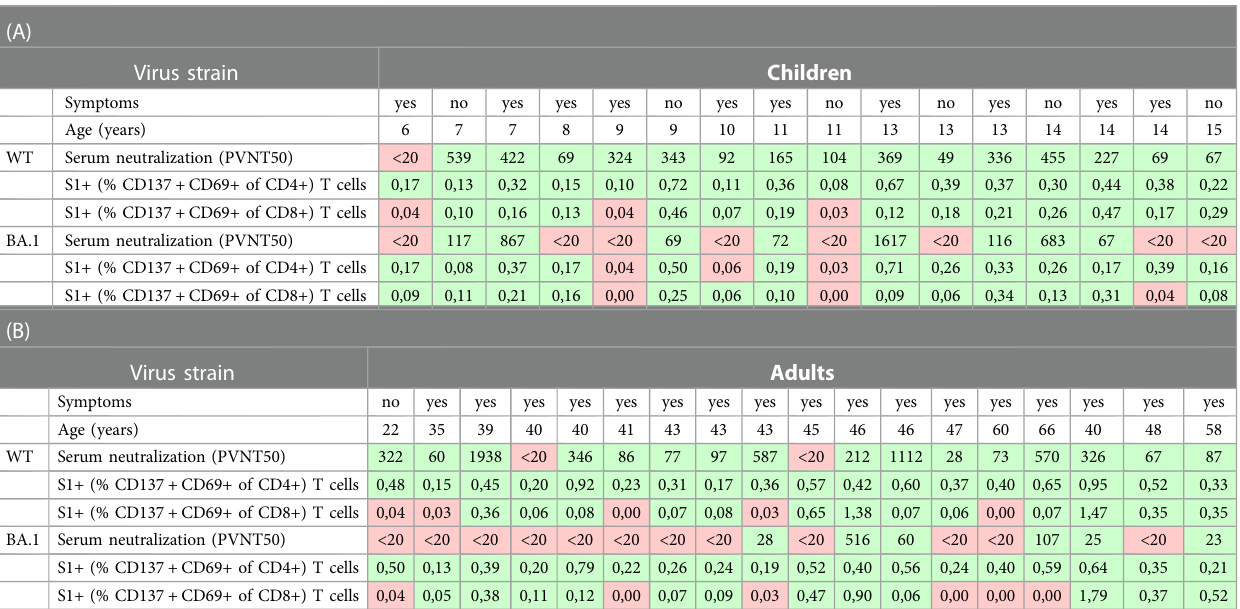
TABLE 2 Presentation of the numeric data of the participants in whom the serum neutralization and S1-speci fi c T cells were measured (18 adults, 16 children) together with age and information on presence of clinical symptoms (see Table 1 for further patients ’ characteristics). The positive values (above cut-off) are shown with green, the negative ones with red background. All values correspond with the data in graphs in Figure